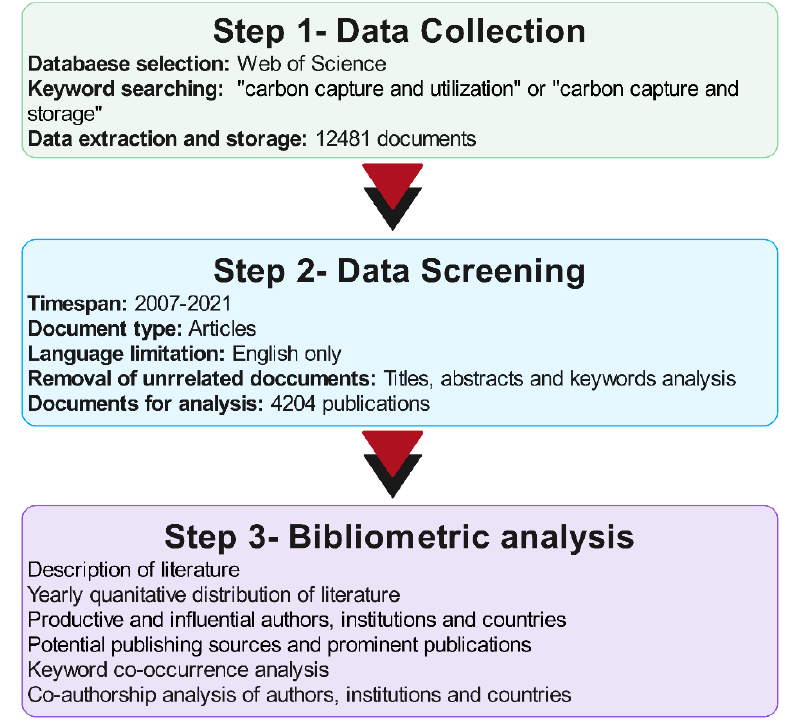
Figure 1. Description of the literature investigation step involving methodology.